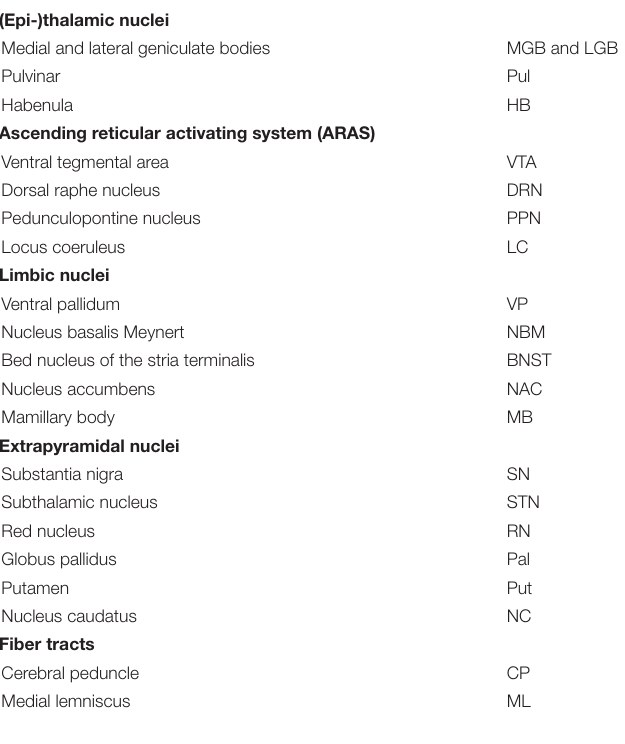
TABLE 2 | Groups of nuclei and fiber tracts with abbreviations.